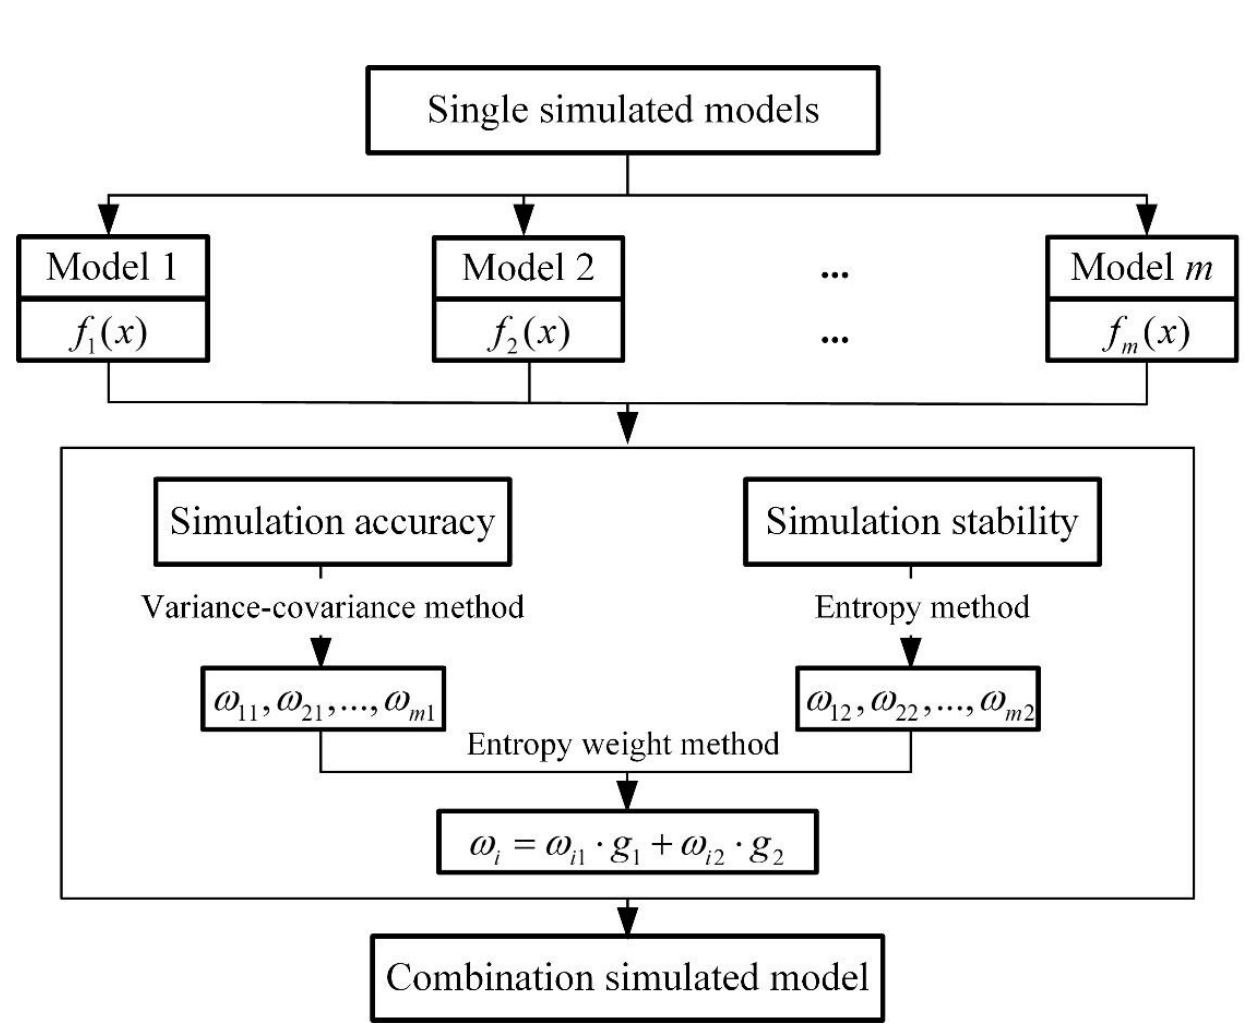
Figure 2. The structure diagram for the weight determination of runoff simulation using the CHSH model.